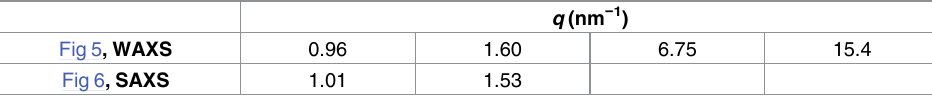
Table 1. Compilation of the angular location of characteristic